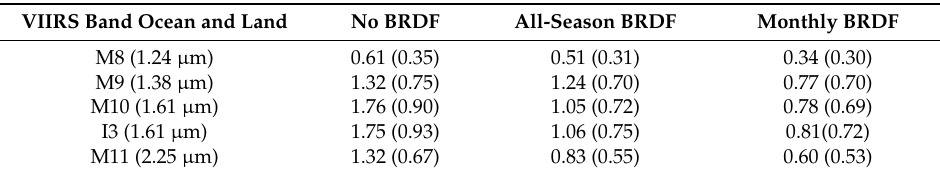
Table 1. Comparison of temporal standard error in percent for VIIRS SWIR bands using no, all-season, and monthly DCC BRDF corrections for tropical ocean and land. The standard errors in parenthesis are after deseasonalization.